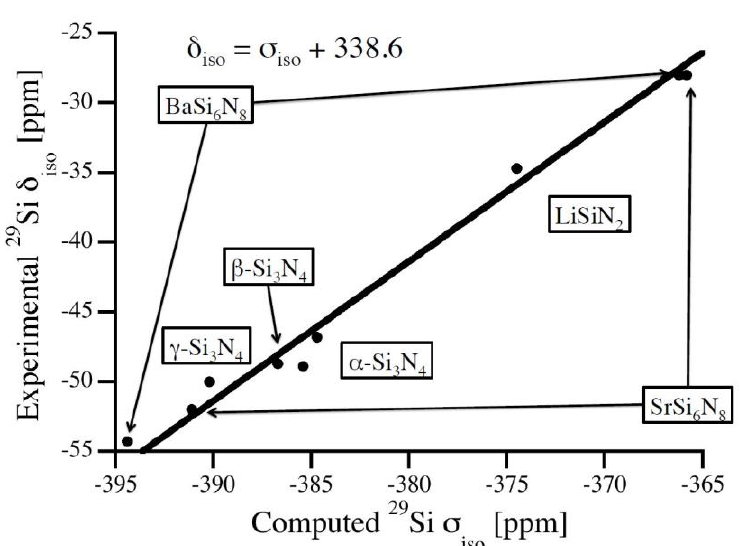
Figure 1. Relation between experimental data and computed absolute 29 Si NMR chemical shifts of Si sites in a variety of crystalline silicon nitrides. The calibration curve is a linear fit (unit slope) to the data. Table 1. Experimental 29 Si NMR chemical shifts, δ iso , computed absolute shifts, σ iso , and predicted δ iso of Si sites in a variety of crystalline silicon nitrides. The predicted value δ isocalc is based on a fit to the data; see Figure 1 and Equation (1).